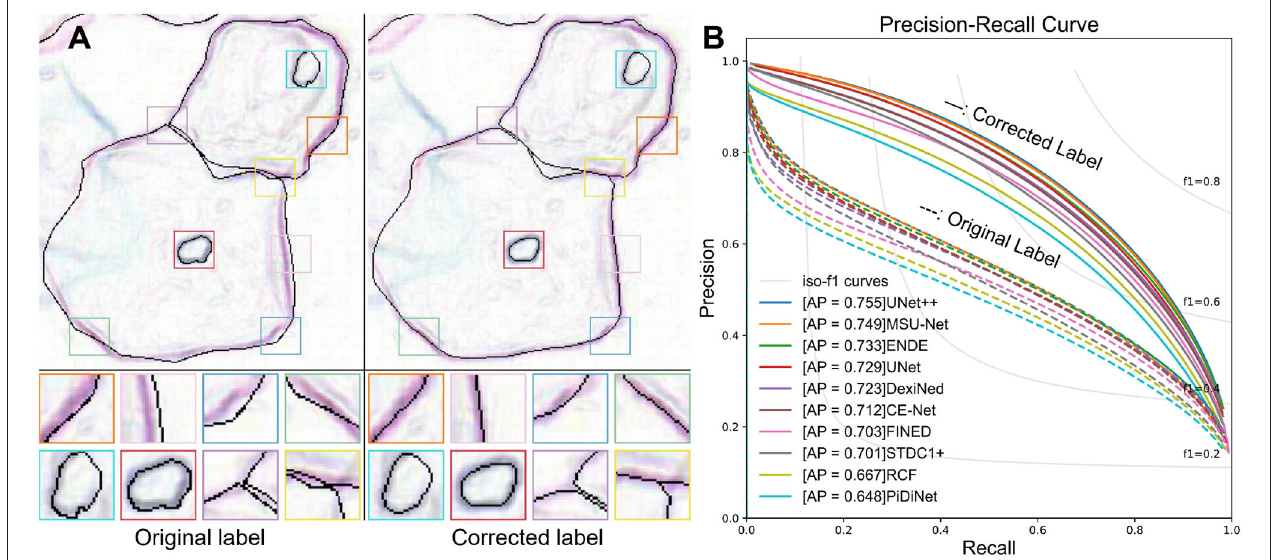
FIGURE 1 | (A) Visual comparison of the original label and our corrected label. Our LLPC can improve the edge positioning accuracy and generate more accurate edge labels. (B) Precision-Recall curves of edge detection methods on our CCEDD dataset. The average precision (AP) is significantly improved over multiple baseline models by using our corrected